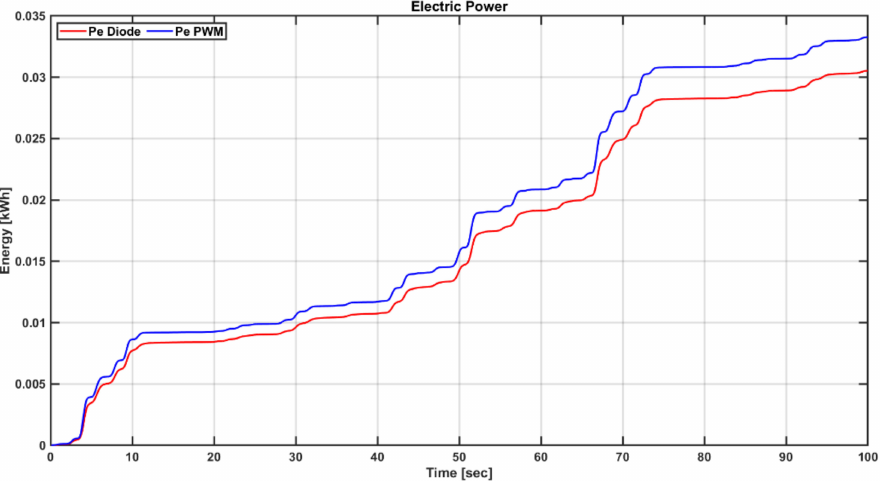
Figure 24. Output energy comparison of PTO system integrated simulation under irregular wave ( v t = 0~30 m / s and Tp = 4.75